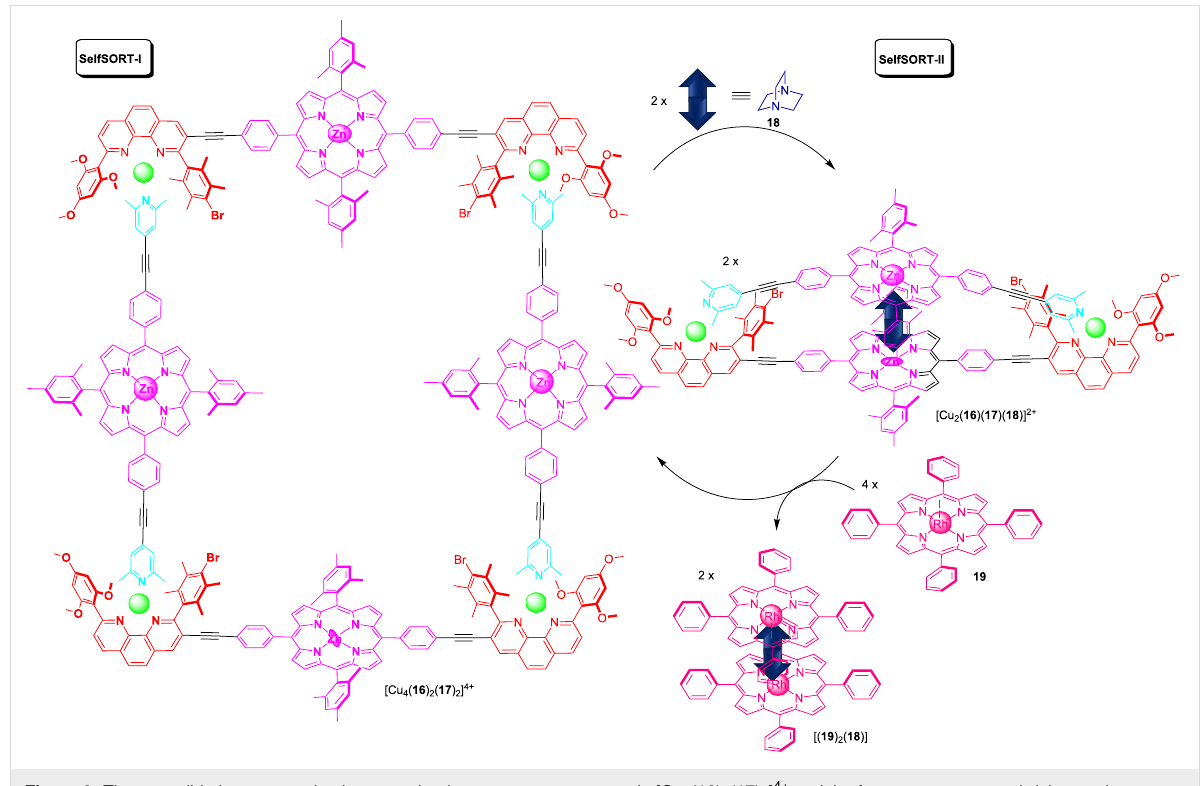
Figure 8: The reversible interconversion between the three-component rectangle [Cu 4 ( 16 ) 2 ( 17 ) 2 ] 4+ and the four-component sandwich complex [Cu 2 ( 16 )( 17 )( 18 )] 2+ .